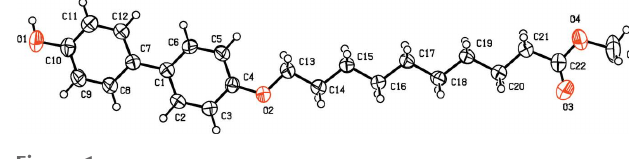
Figure 1 View of the molecular structure of MBO10Me , showing the atom-labeling scheme. Displacement ellipsoids are drawn at the 50% probability